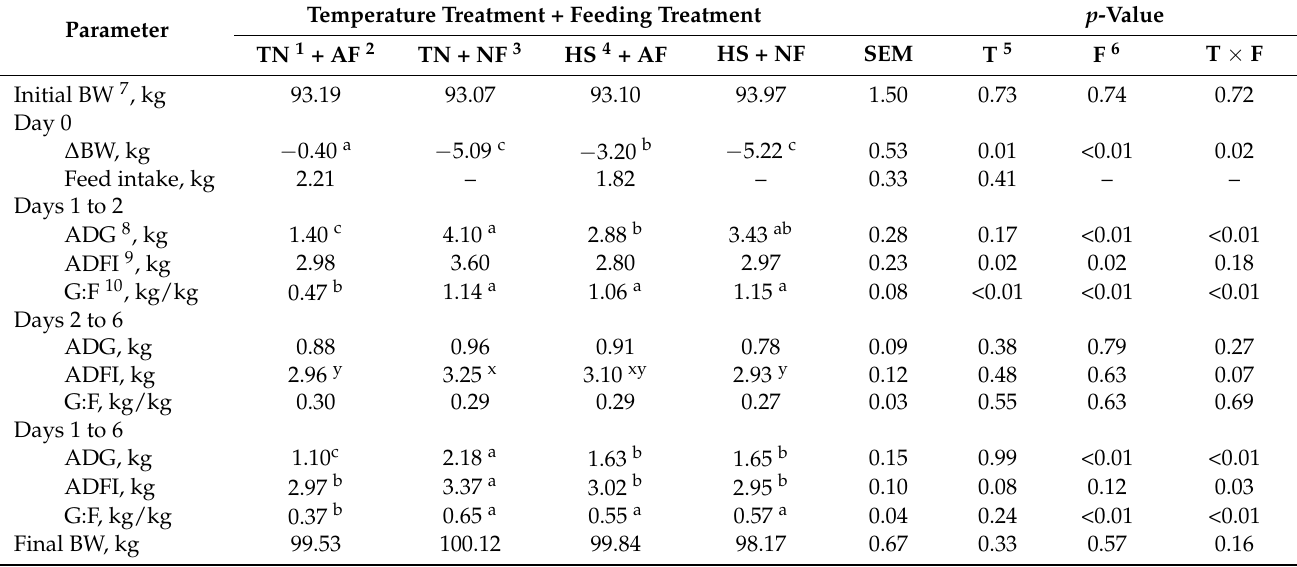
Table 3. Growth performance monitored during the 24 h temperature and feeding treatment (TF) period (Day 0) and Days 1 to 2, 2 to 6, and 1 to 6 of the post-TF period in finishing